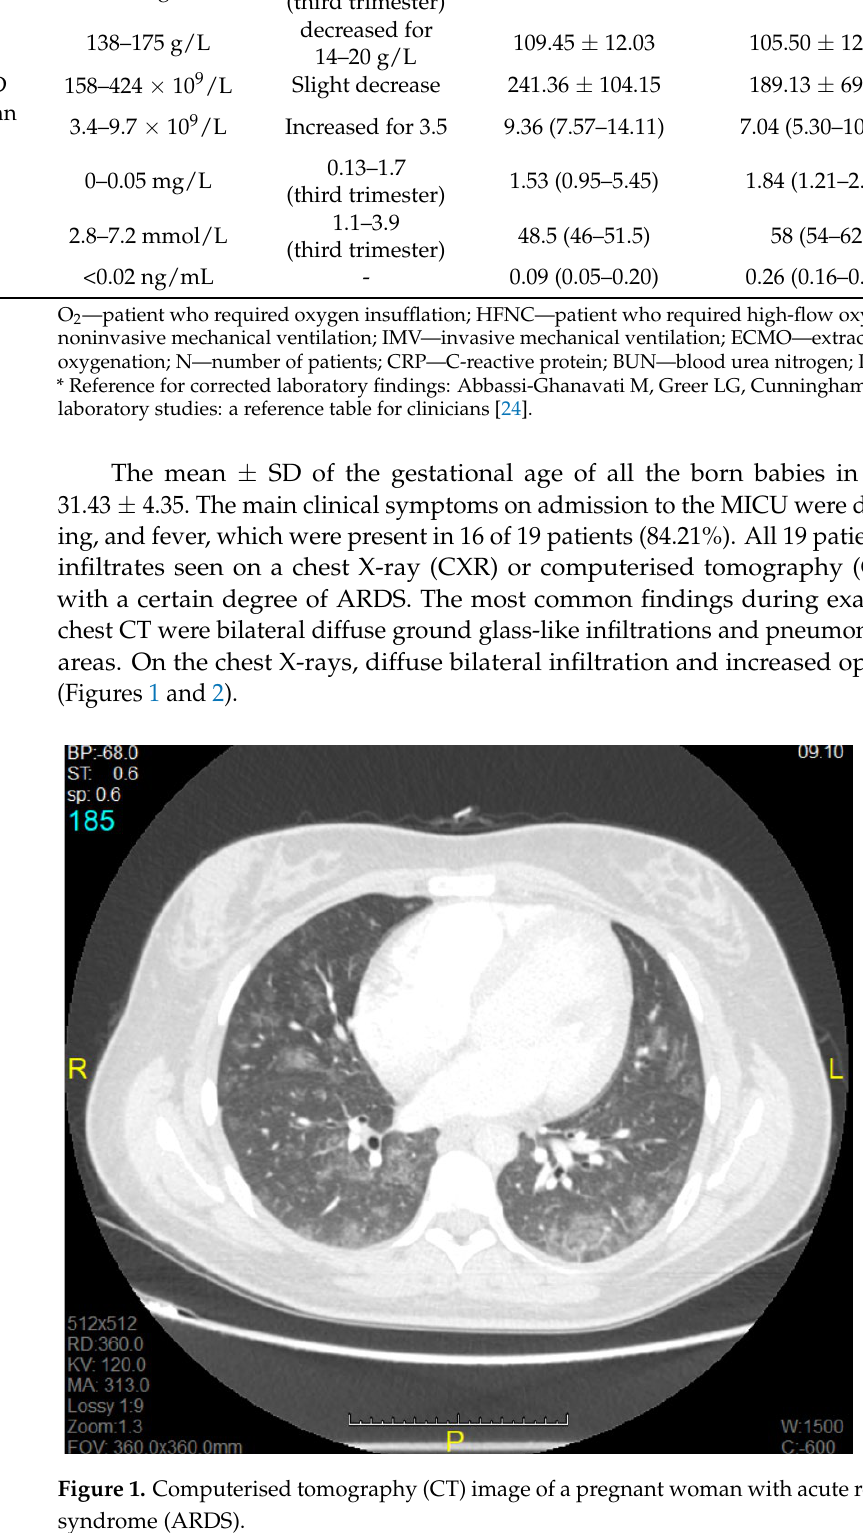
Figure 2. Chest X-ray showing diffuse opacity and infiltrates in a postpartum woman treated with vvECMO. None of the pregnant women observed in this study had severe respiratory disease pre-pregnancy or family genetic disorders, nor any other significant comorbidities